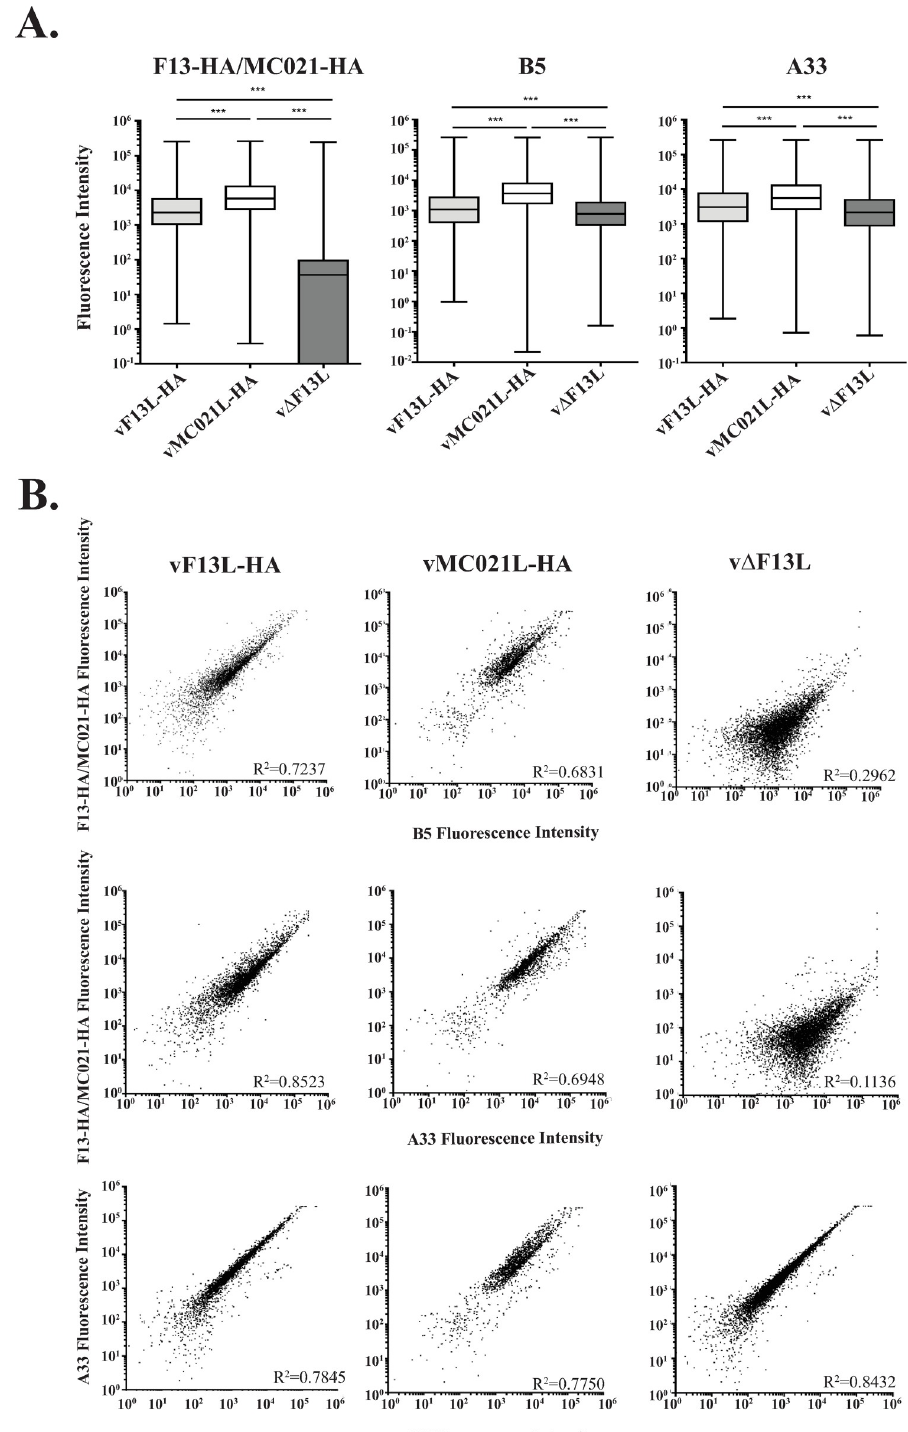
Fig 2. EV glycoprotein content analyzed by flow virometry. (A) RK13 cells were infected with the indicated viruses at a MOI of 5 and incubated at 37˚C overnight. The next day, progeny virions released into the media (EV) were centrifuged through a sucrose cushion, fixed, and stained with rabbit anti-HA antiserum followed by Cy2-conjugated donkey anti-rabbit antibody, rat anti-B5 MAb followed by Dylight 405-conjugated donkey anti-rat antibody, and rabbit anti-A33 antiserum followed by Alexa Fluor 647-conjugated donkey anti-rabbit antibody. Shown are